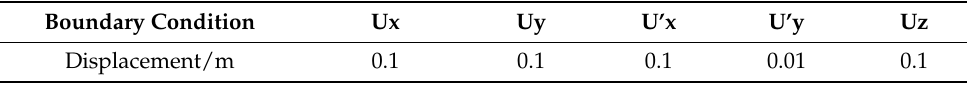
Table 3. Boundary condition of the numerical model.